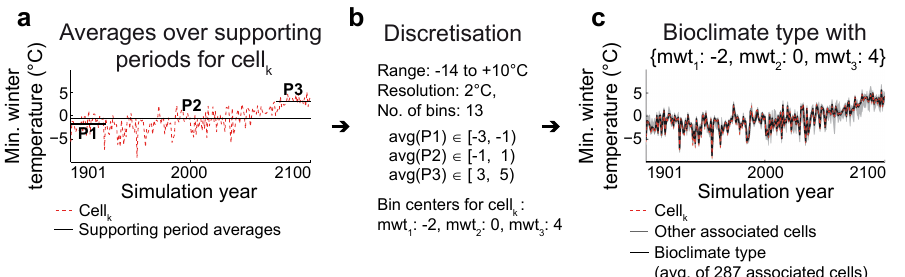
Figure 3. Visualisation of the pre-structuring into bioclimate types on the example of the minimum winter temperature (min. winter temper- ature), one of TreeMig’s three bioclimate drivers. (a) The minimum winter temperature driving cell k is averaged for each of the supporting periods (here P1: 1901–1930, P2: 1901–2100, P3: 2071–2100). (b) The range of the minimum winter temperature ( − 14 to + 10 ◦ C) is dis- cretised into 13 bins with a resolution of 2 ◦ C (as e.g. done for E3, the set of bioclimate bins with the coarsest resolution – see e.g. Table 2). The averages of the supporting periods P1–P3 for cell k are classified according to these bins. (c) Cells whose averages fall into the same bin in each of the supporting periods for each of the bioclimate drivers are classified into the same bioclimate type. The bioclimate driver (here the minimum winter temperature) of the bioclimate type is calculated as the average (black line) of its 287 associated cells (grey